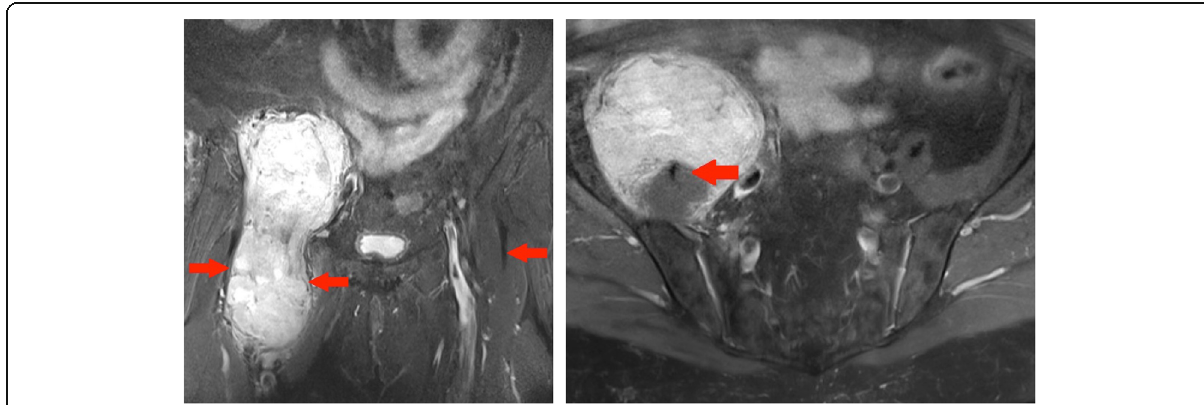
Fig. 15 Left panel: Coronal T1 TIRM MR image of the pelvis: right-sided large heterogeneous tumour with areas of internal fat component demonstrating suppression on this fat saturated sequence. The paucity of fat components and the nodularity of the lesion suggested that radiologically this is a high grade, undifferentiated sarcoma. Right panel: Axial T1 TIRM MR image of the pelvis: the lesion is in continuity with the right iliopsoas and the red arrow outlines the iliopsoas